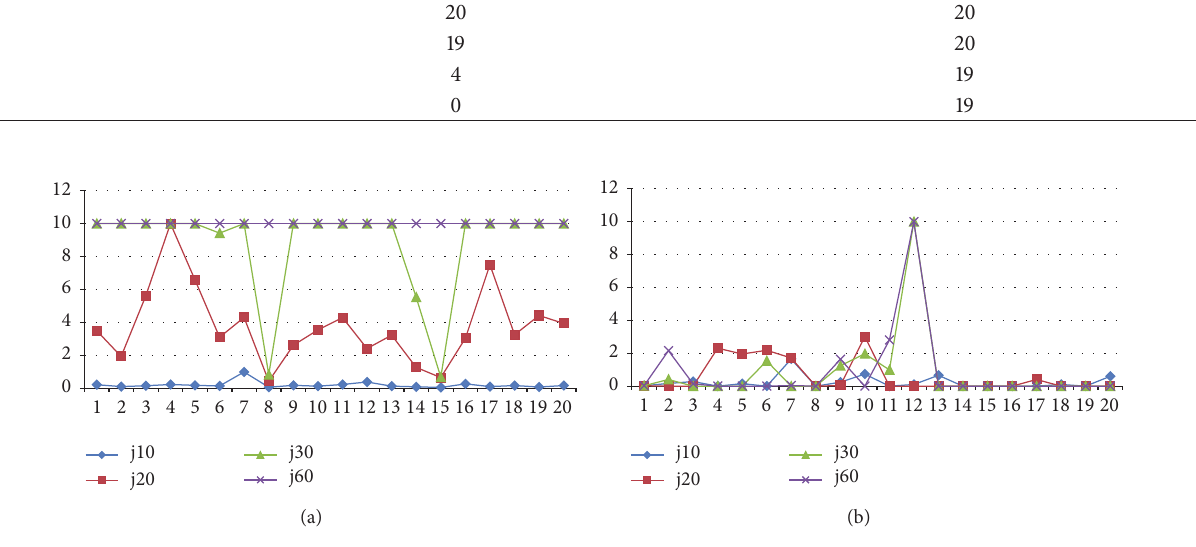
Figure 1: Solving time (seconds) of the instances of group I by (a) the CPLEX Solver and (b) the branch and bound